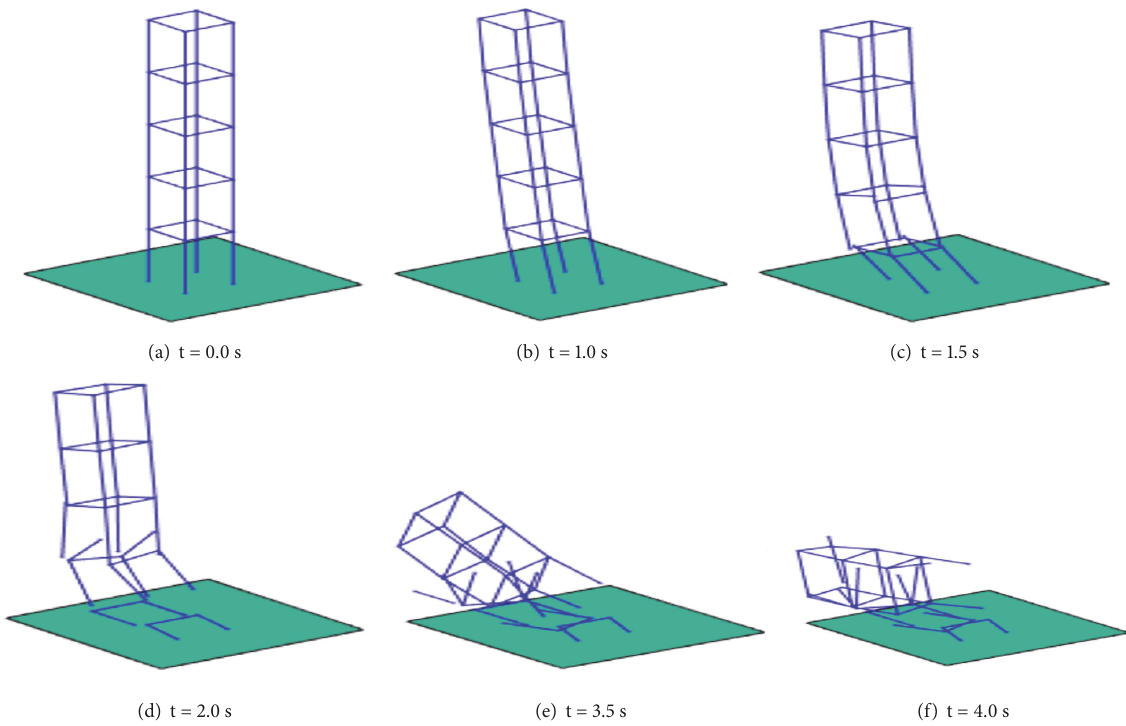
Figure 22: Collapse process of space steel frame.